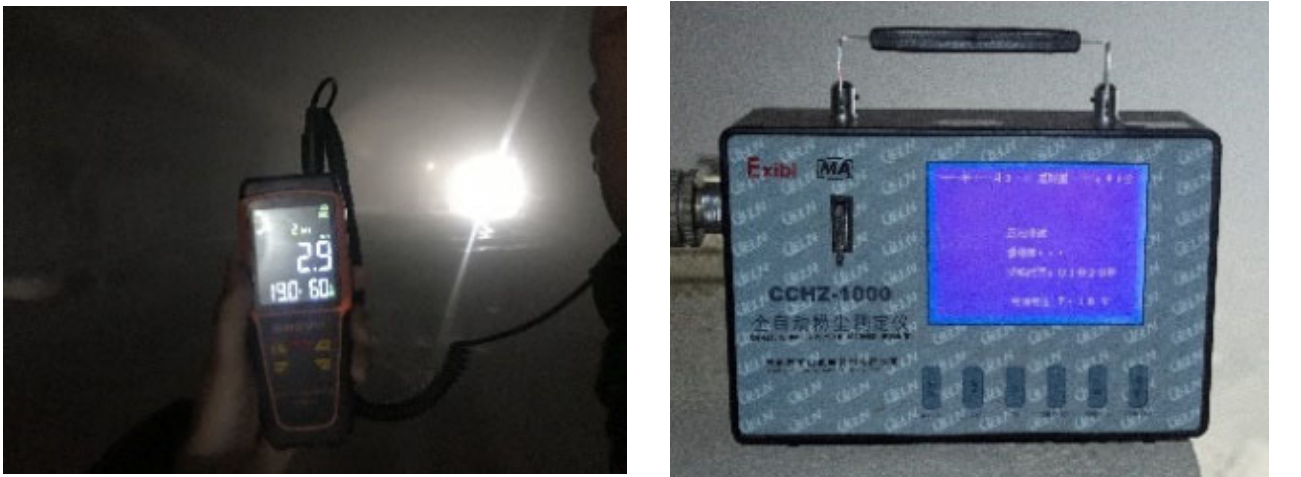
Figure 7. Test instrument.